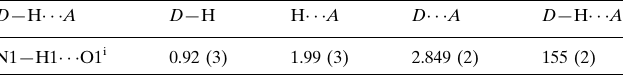
Hydrogen-bond geometry (A˚ , (cid:1)